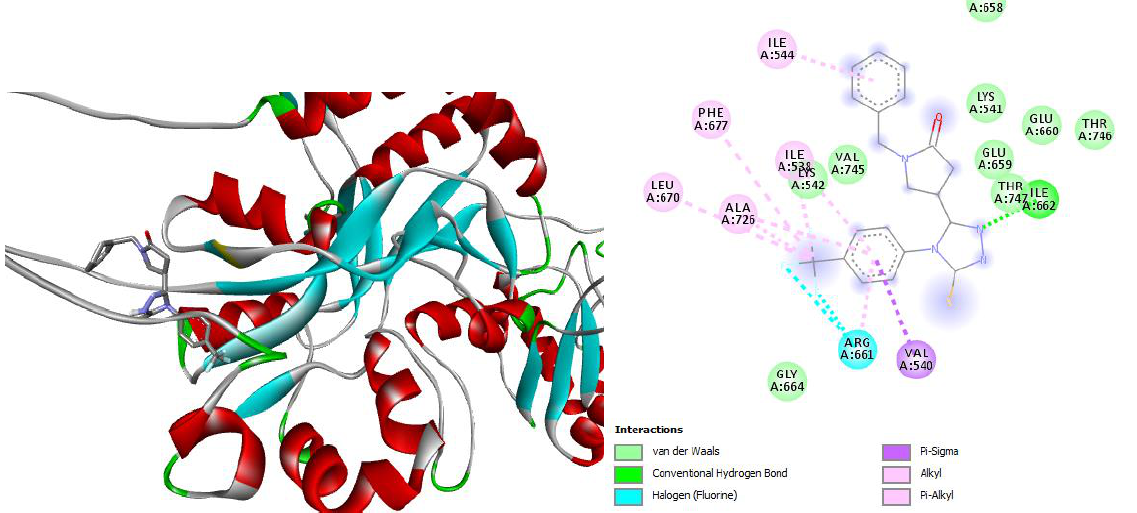
Fig. 2. Superposition of molecule 2 and diagram of intermolecular interactions in complex with N-methyl-d-aspartate receptor (NMDAR) (PDB ID: